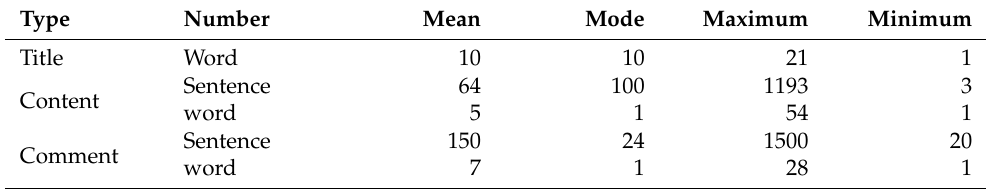
Table 3. Cyberbullying data statistics.